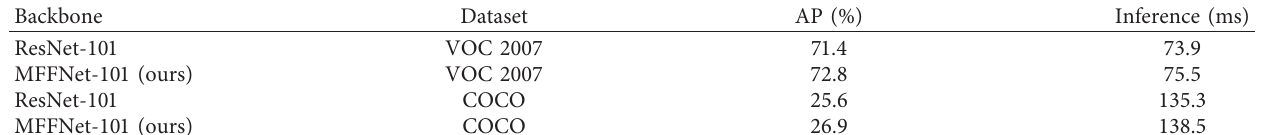
Figure 8: Grad-CAM visualization results, using ResNet-50 and our proposed MFFNet-50 with atrous rates r � 1 , 2 , 4 { } as the backbone networks. Table 7: Object detection. The detector is Faster-RCNN. Atrous rates r � 1 , 2 , 4 { } .